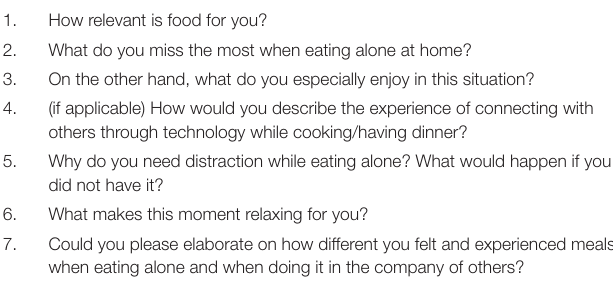
TABLE 1 | Overview of interview